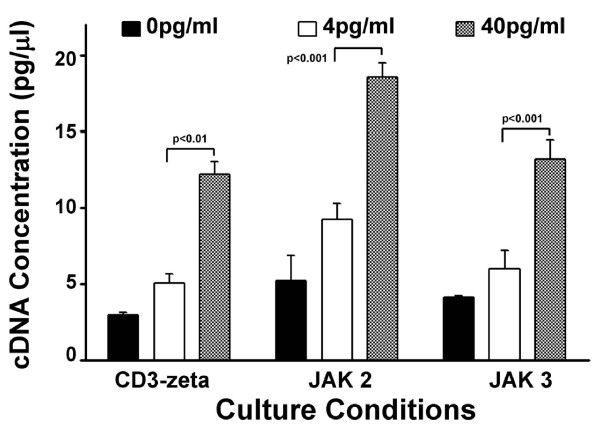
Suppression of CD3-zeta, JAK 2 and JAK 3 mRNA levels by physiologic estradiol concentrations. Suppression of mRNA levels for CD3-zeta, JAK 2, and JAK 3 by exposure to 4 pg/ml versus 40 pg/ml estradiol quantified by real-time PCR. Results are presented as a mean ± standard deviation of cDNA concentration, resulting from duplicate runs.